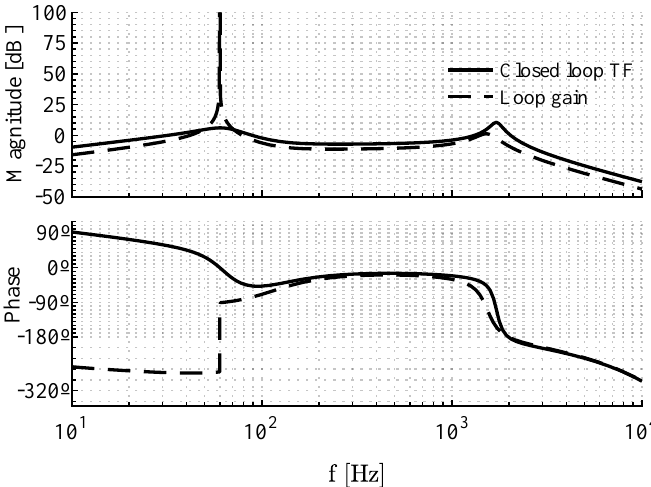
Figure 17. Bode plots for the CLTF and the loop